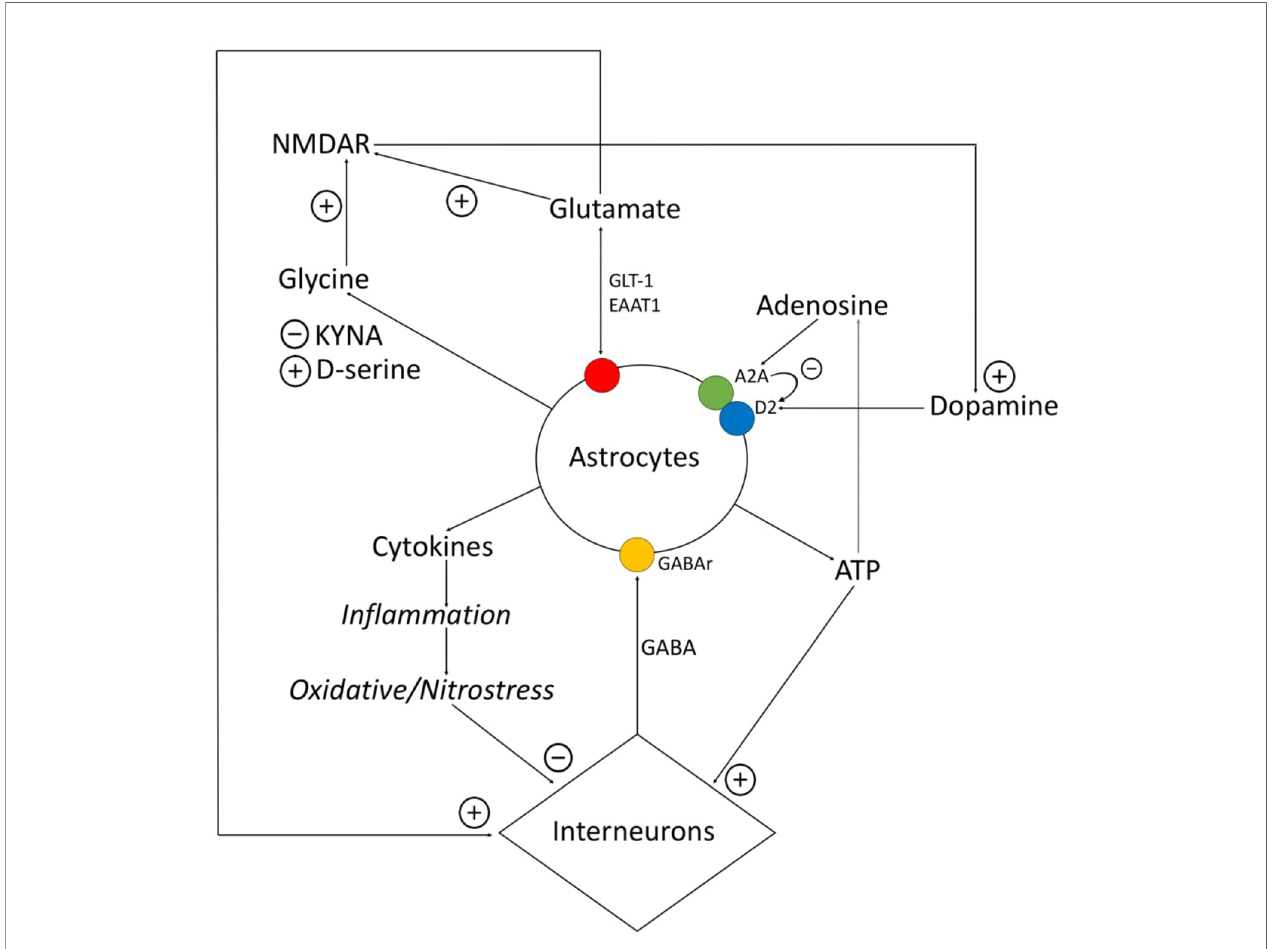
FIGURE 1 | Relationship between astrocytes, interneurons, and transmitters. Astrocytes express proin fl ammatory cytokines, which provokes the destruction of gamma-aminobutyric acid (GABA)ergic interneurons. GABA in fl uences on astrocytes and via Ca 2+ -dependent stimulates expression of different gliotransmitters (glutamate, ATP, cytokines). Glutamate and ATP have an activating impact on interneurons. Adenosine operates on A2A receptors of astrocytes, related with the dopamine receptors, and inhibits them. Astrocytes control the amount of glutamate via glutamate transporter (GLT)-1, excitatory amino acid transporter (EAAT)1, and also metabotropic glutamate receptors (mGluRs). Astrocytes express D-serine and kynurenic acid (KYNA), while D-serine is the agonist of N-methyl-d-aspartate (NMDA)-receptors, and KYNA is the antagonists of glycine site of NMDA-receptors. NMDA-receptors activate dopamine